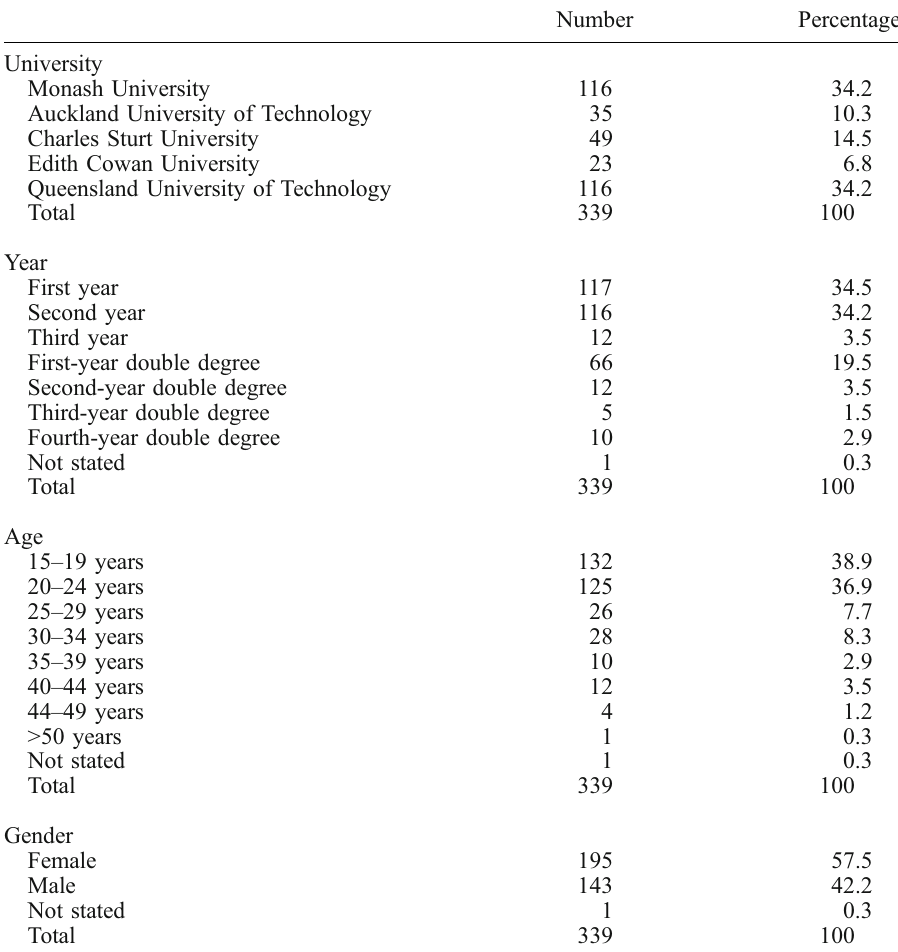
Table 2. Participant pro fi